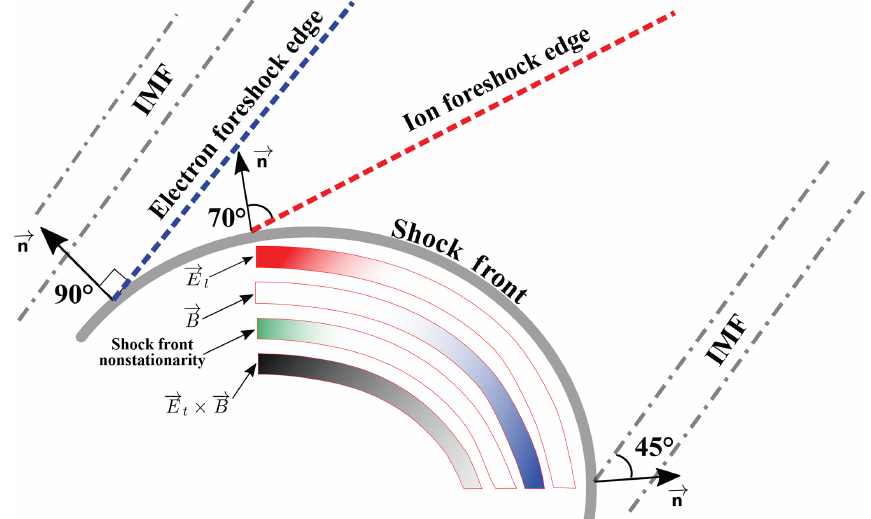
Figure 11. Sketch of the ion foreshock in the quasi-perpendicular shock region, illustrating the angular areas along the curved front where the four main identified processes contributing to and/or impacting on the formation of back-streaming ions apply (namely the longitudinal electric field E l , the magnetic field, the shock front nonstationary and the convective electric field E t ). Each process is illustrated by different thick band along the curved front which is shifted, one from the other, in order to avoid overwhelming the sketch. One color (red, blue, green and black, respectively) is associated to each process. The varying intensity of the color indicates where the process is strong (full color) or weak (white). This allows one to identify, at a glance, the angular areas where the different processes are complementary or accumulating. The upstream interplanetary magnetic field (IMF) is reported in gray (dotted and dashed lines), as is the shock front itself. Typical directions θ Bn = 90 and 70 ◦ (blue and red dashed lines) defined between the local shock normal n and the IMF indicate the location where the electron and ion foreshock edge initiates from the curved shock front, respectively. The electron foreshock edge is indicated as a